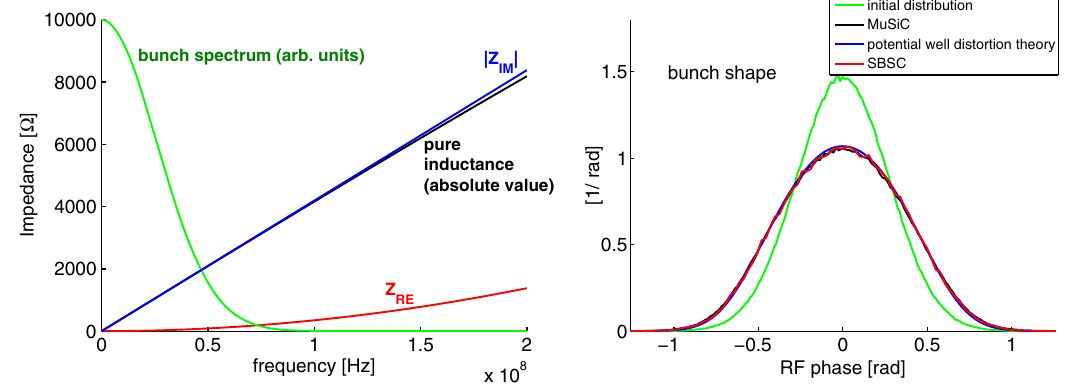
FIG. 15. Left side: Bunch spectrum, real and imaginary part of a broadband impedance compared with a pure inductance. Right side: Bunch shape resulting from M U S I C with the broadband impedance of the left side, from the potential well distortion theory with a pure inductance, from SBSC using slices.